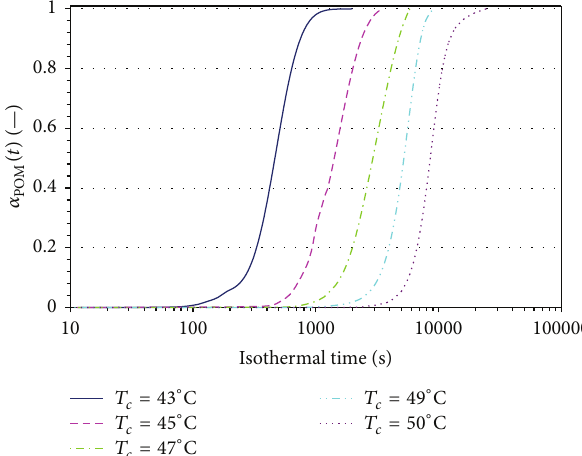
Figure 7: Evolution of 𝛼 (defined by (2)) in isothermal crystal- POM